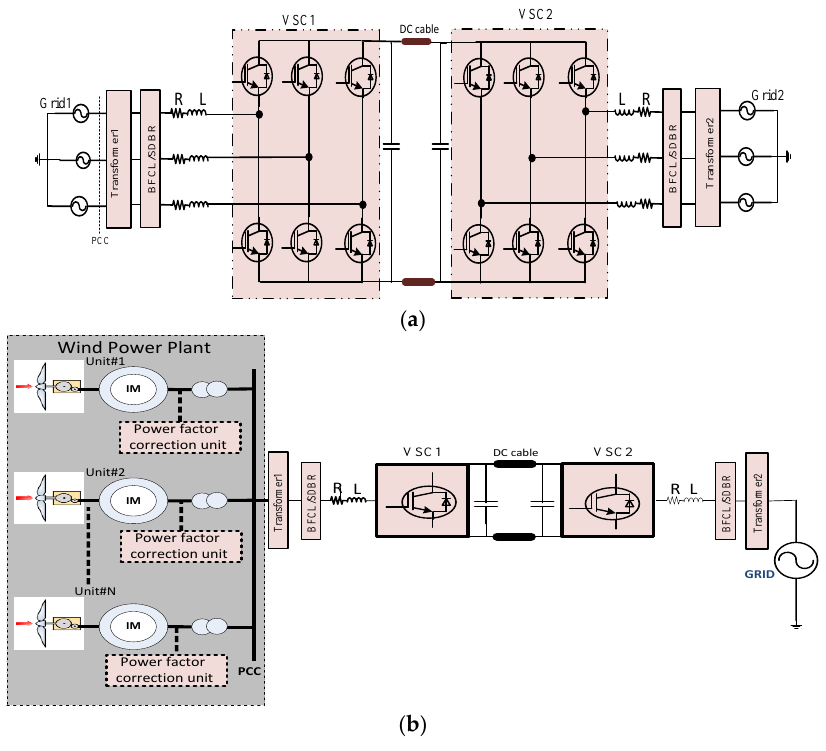
Figure 2. Schematic diagram of VSC-HVDC systems ( a ) Two grids connected mode ( b ) Wind farm integrated mode.